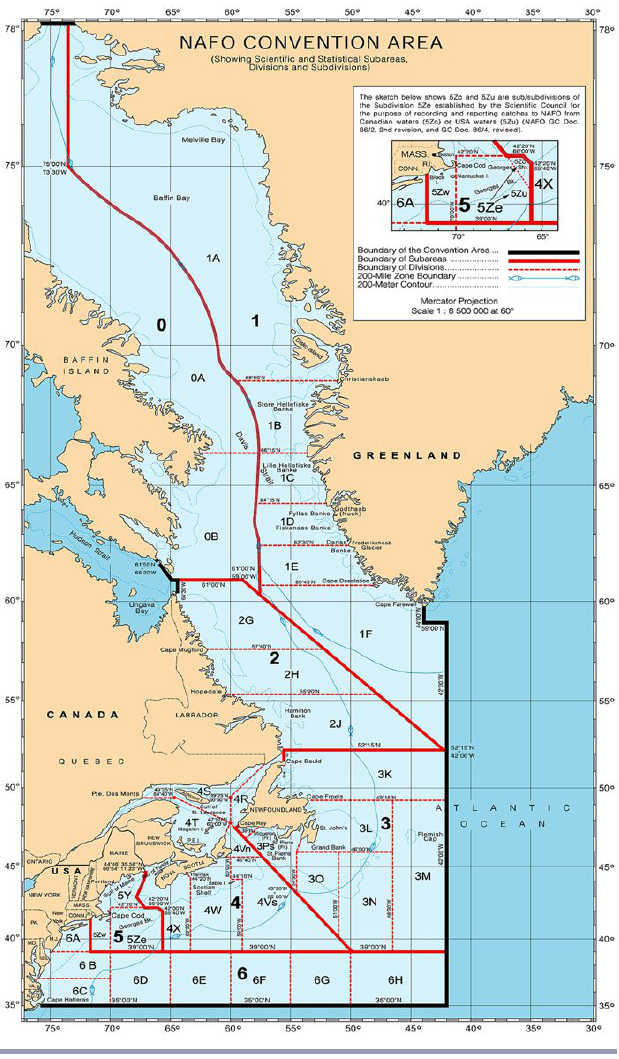
Fig. 1 . Geographic delineations of the Northwest Atlantic Fisheries Organization (NAFO) Convention Area. Taken